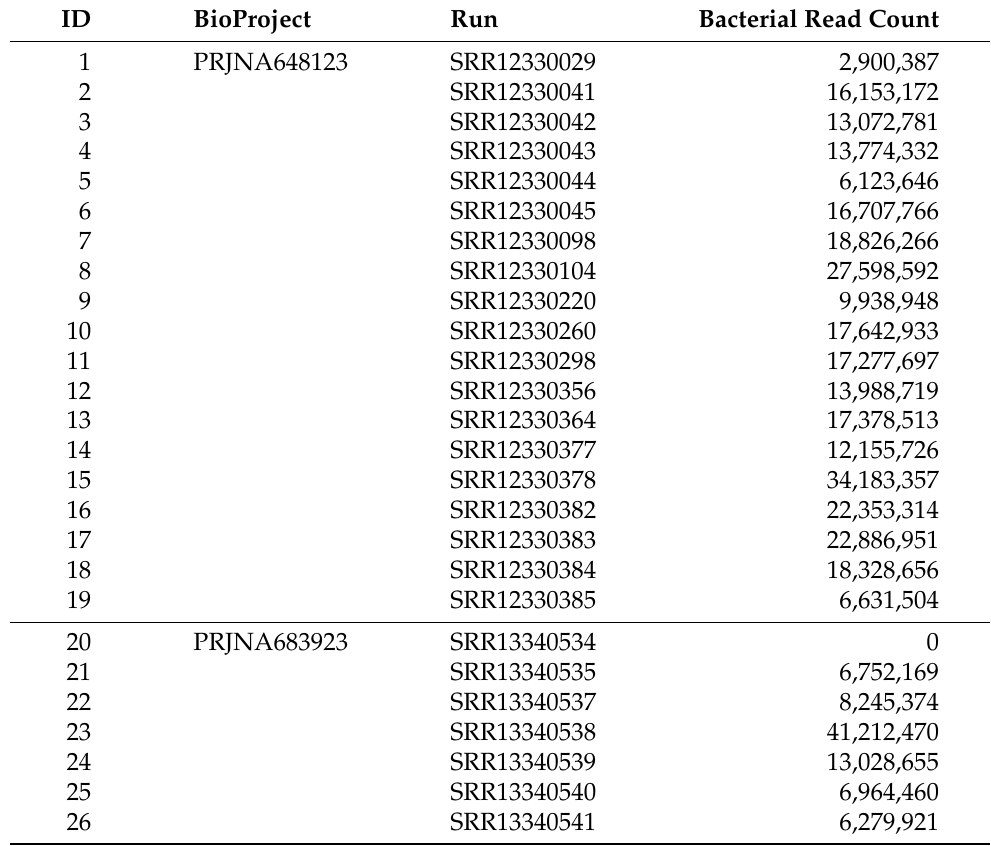
Table 1. The list of analyzed samples was obtained from the National Center for Biotechnology Information Sequence Read Archive. Column Run contains the NCBI SRA run identifiers. Bacterial read count represents the number of reads that were classified taxonomically to any